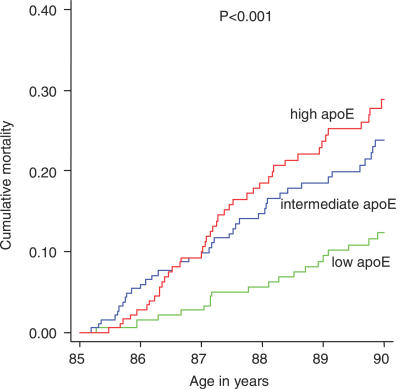
Kaplan-Meier Mortality Curve for Tertiles of ApoE LevelsPlasma apoE is indicated at high (red), intermediate (blue) and low (green) levels, showing that high plasma apoE levels associate with increased cardiovascular mortality. The
p-value indicates the statistical significance of the association of plasma apoE level with cardiovascular mortality in a sex-adjusted Cox proportional hazards model.